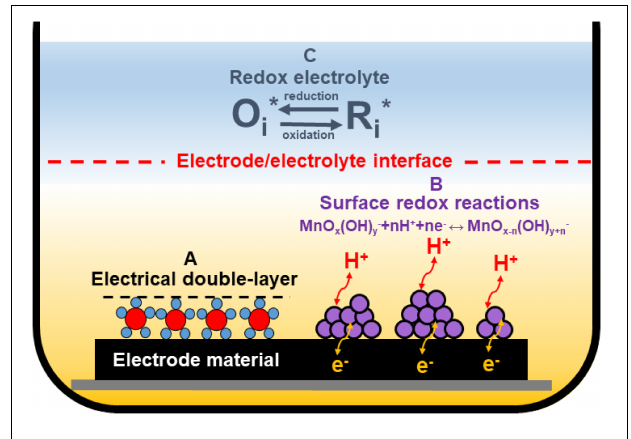
FIGURE 3 | Various charge storage mechanisms in ECs: electrical double-layer formation (A) and surface redox reactions (B) at the electrode/electrolyte interface; redox reactions from the redox-active electrolyte (C)